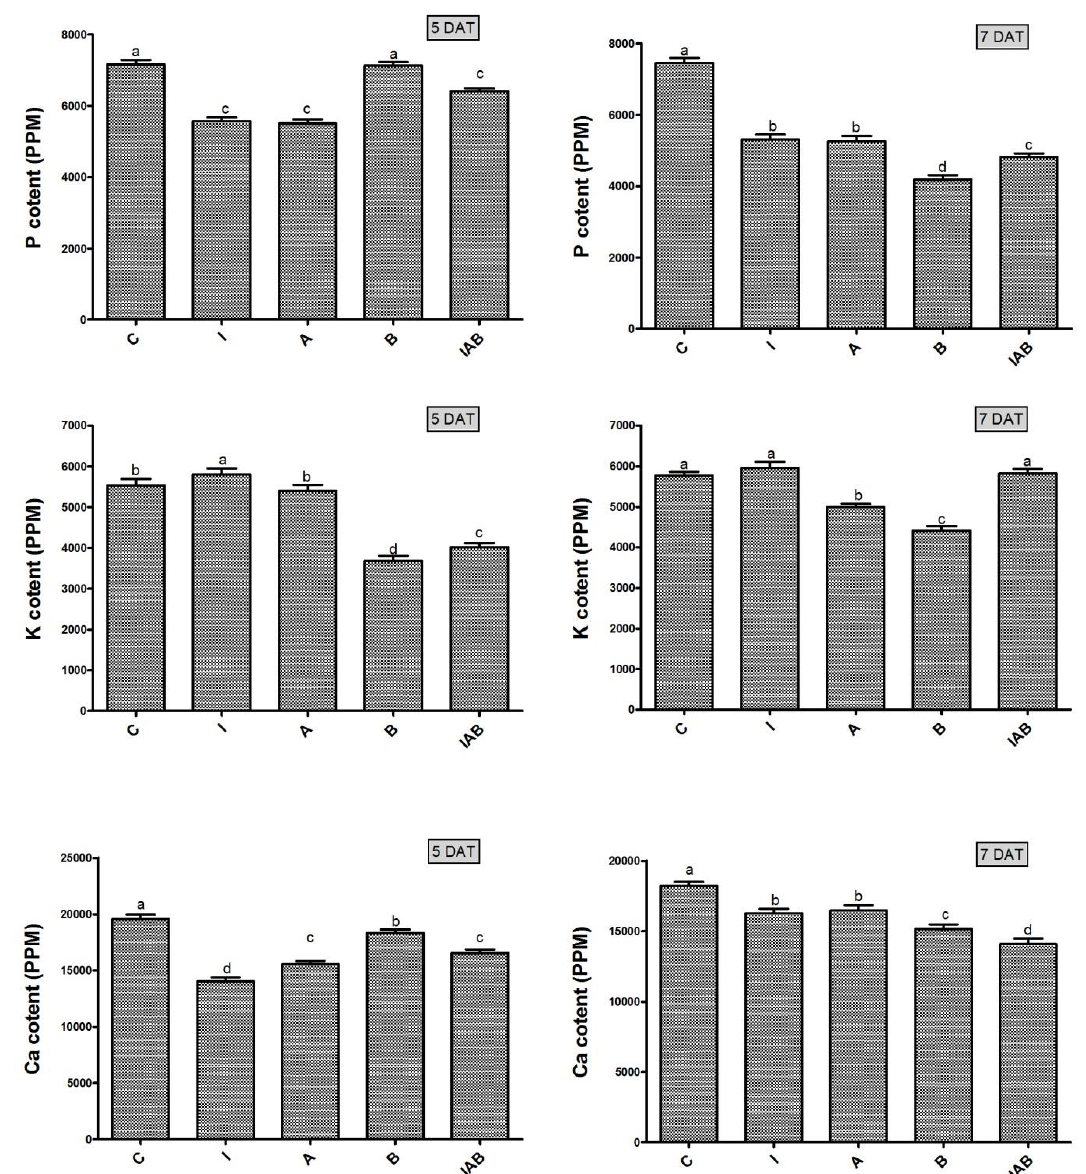
Figure 6. C, control seedlings; I, IAA-treated seedlings; A, ammonia-treated seedlings; B, YNA12-treated seedlings; and IAB, IAA-, ammonia-, and YNA12-treated seedlings. Di ff erent letters on the columns with error bars (mean ± standard deviation) represent significant di ff erences among the treatments. The data were analyzed with a one-way ANOVA followed by Duncan multiple range test ( p < 0.05).